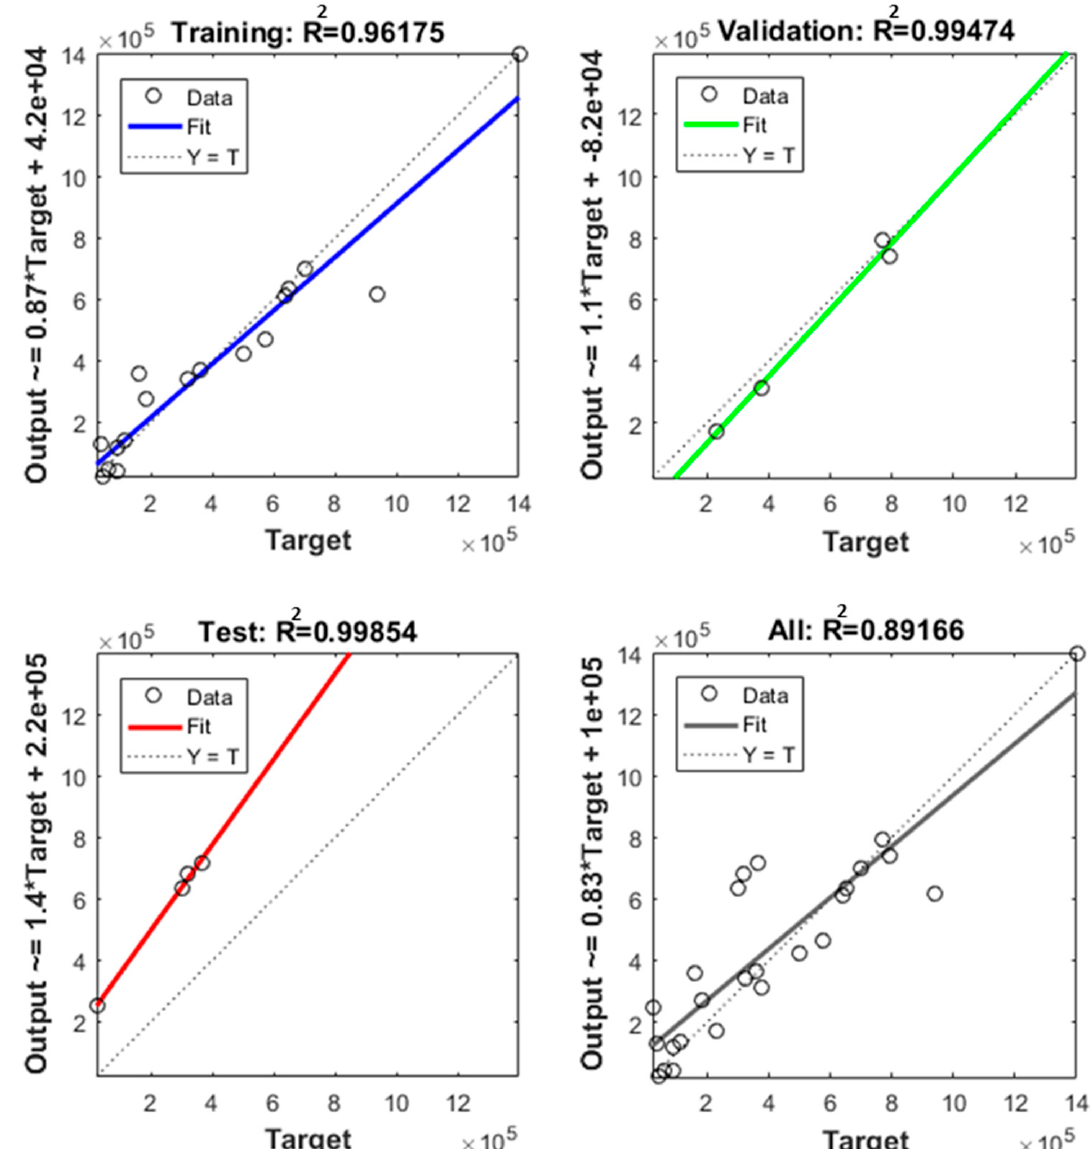
Figure 8. Accuracy of fitted curve of trained model.